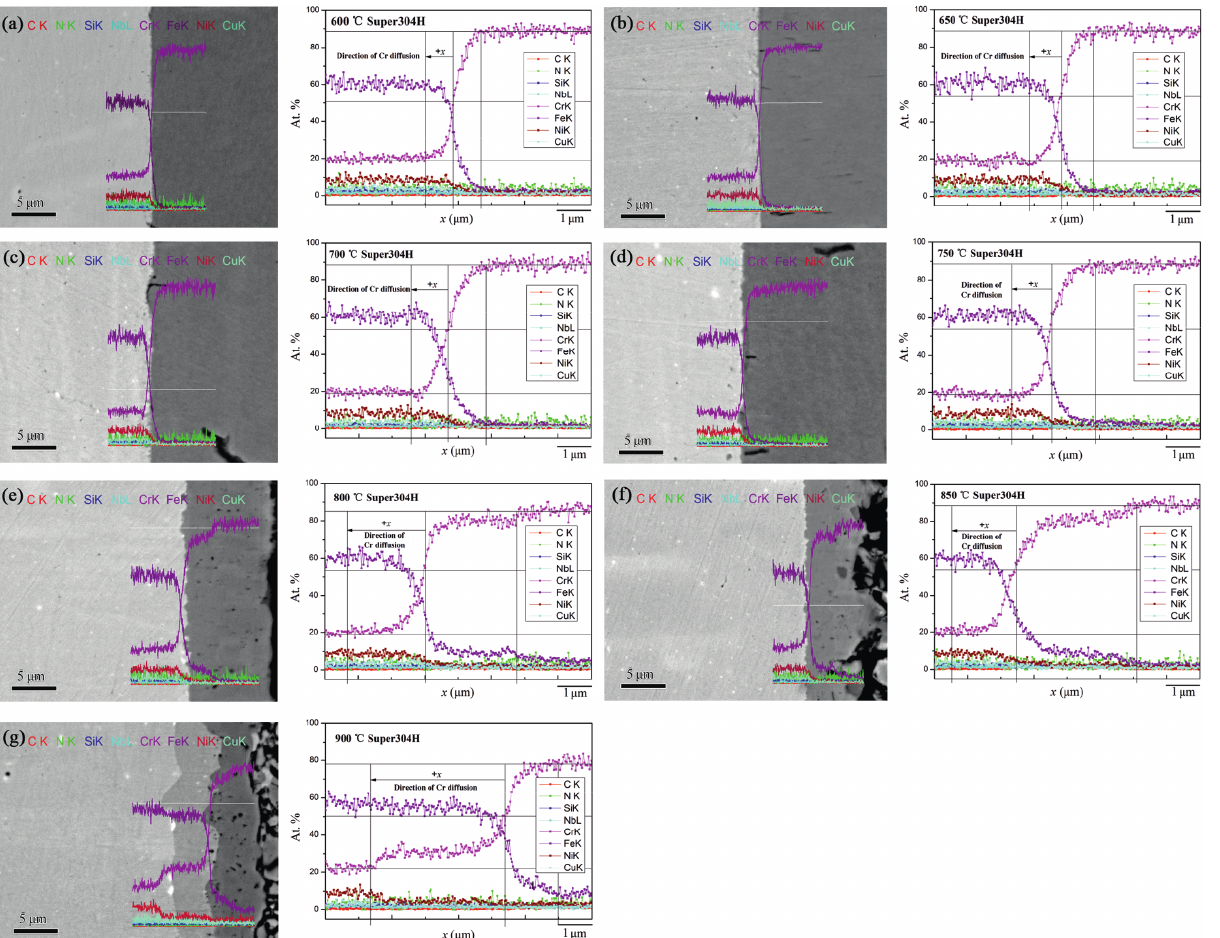
Figure 3: Left: Quantitative line scan spectrum across the bonding interface of Super304H diffusion couples after vacuum heat treatment at different temperatures for 50 h; Right: Corresponding Cr diffusion profiles (in at.%) across the bonding interface (a) 600 ℃ ; (b) 650 ℃ ; (c) 700 ℃ ; (d) 750 ℃ ; (e) 800 ℃ ; (f) 850 ℃ ; and (g) 900 ℃